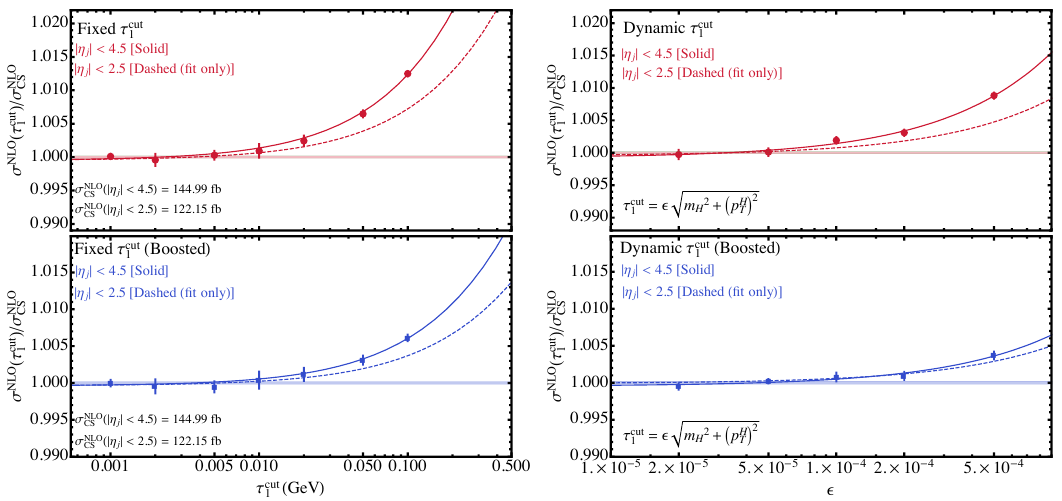
Figure 3 . A comparison of different definitions of the jettiness-slicing parameter for the NLO predictions of H + j . The figures on the left use a fixed definition of τ cut use a dynamic version. The upper panels show the result in the laboratory frame whereas the lower panels evaluate the cut in the rest frame of the H + j